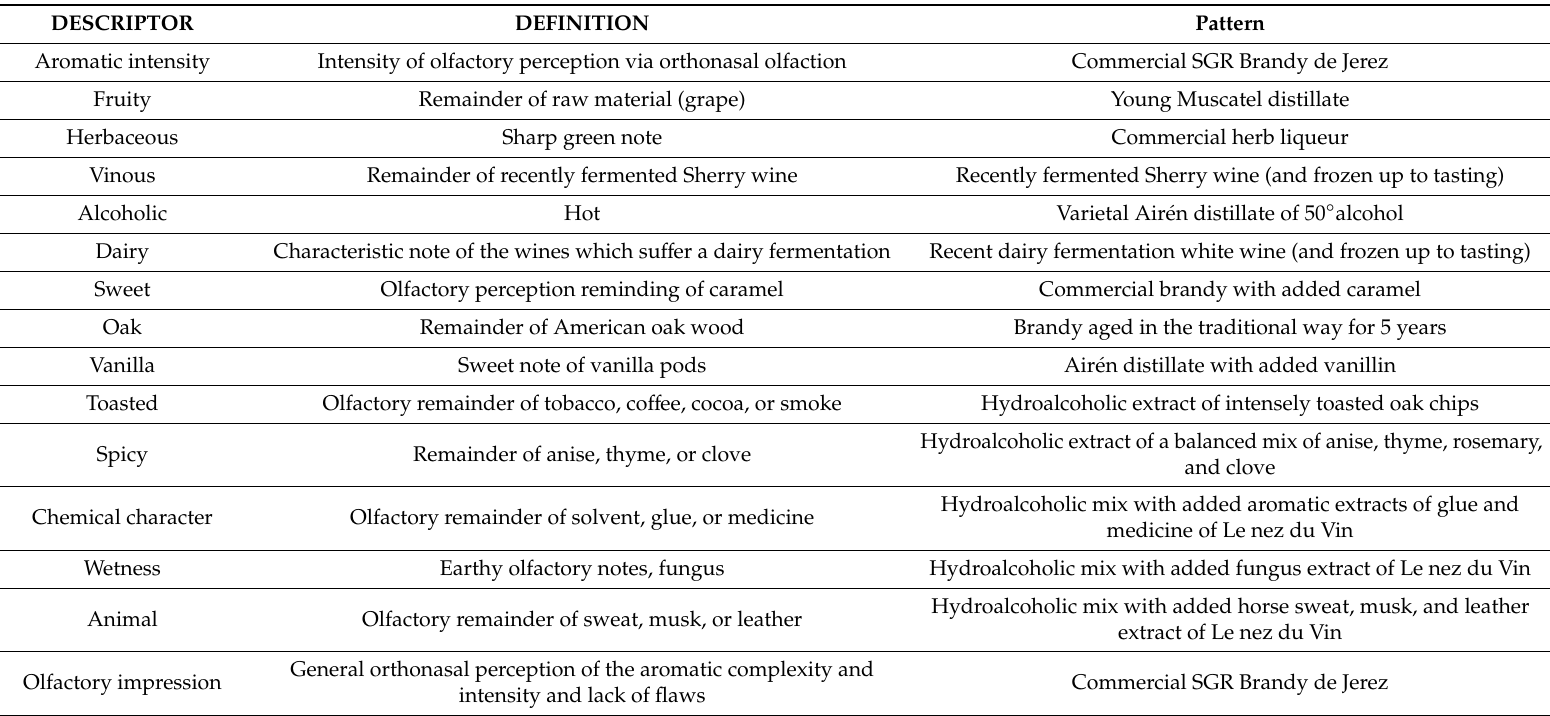
Table 1. Aromatic descriptors used for the assessment of the